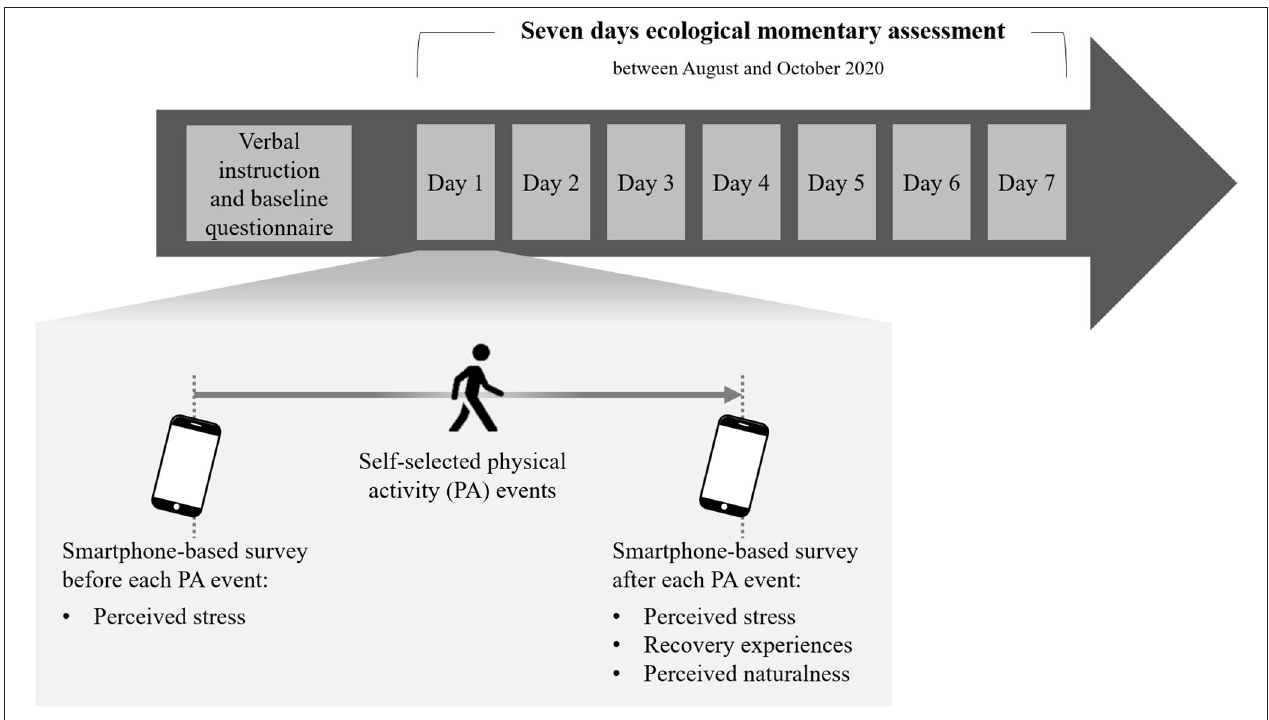
FIGURE 1 | Study procedure.